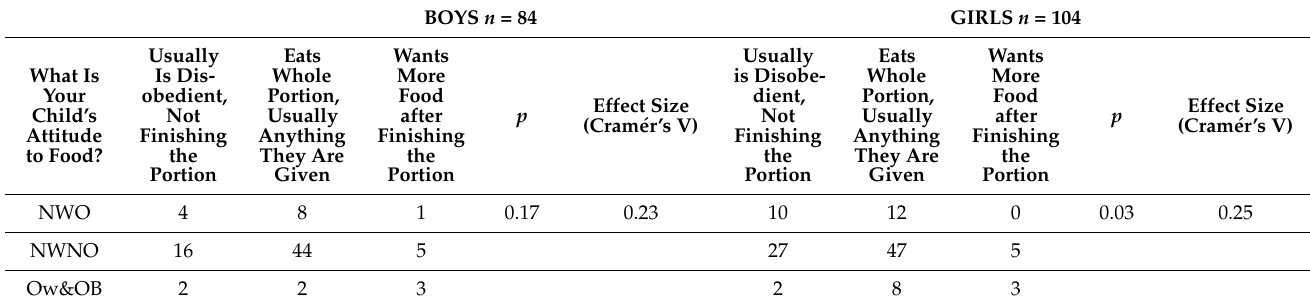
Table 7. Frequencies of responses in polytomous scored items from Czech screening questionnaire for parents monitoring basic eating